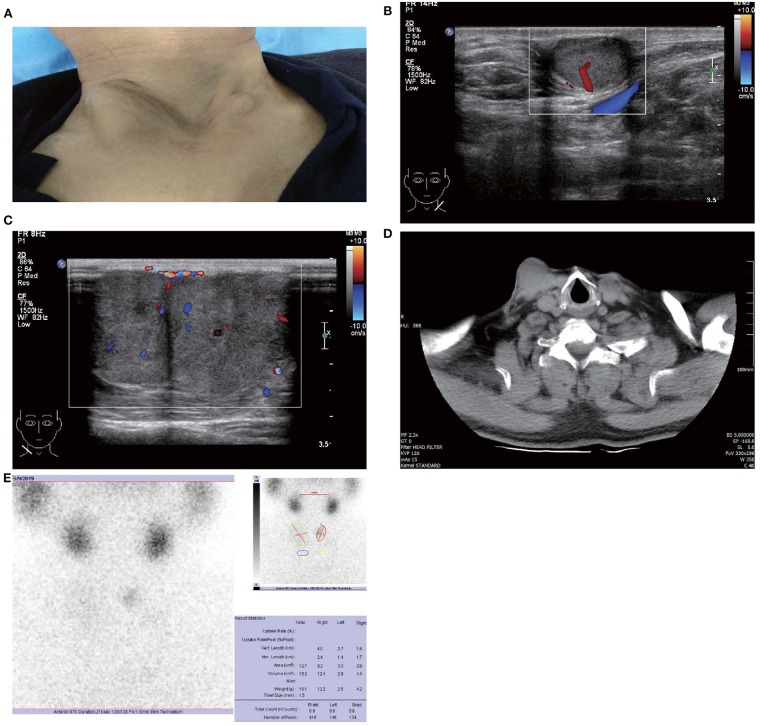
Images of patient and subcutaneous nodules. (A) Multiple subcutaneous soft tissue nodules of metastatic follicular thyroid carcinoma on the anterior neck. (B) Gray-scale ultrasound shows a hypoechoic nodule in the subcutaneous soft tissue of left neck (size were 16 × 11 mm), with wider than taller, well-defined border, irregular margin, perinodular, and intranodular flow and absence of calcification and peripheral halo. (C) Gray-scale ultrasound shows two solid hypoechoic nodules adjacent to each other in the subcutaneous soft tissue of right neck (size of the larger one were 28 × 23 mm), with wider than taller, partially well-defined border, partially regular margin, perinodular and intranodular flow and absence of calcification and peripheral halo. (D) Computed tomography shows several low-density nodules in the subcutaneous of the anterior neck. (E)
99mTcO4-SPECT reveals a shadow of a cold nodule in the right anterior neck region and a shadow of a nodule in the left anterior neck region.